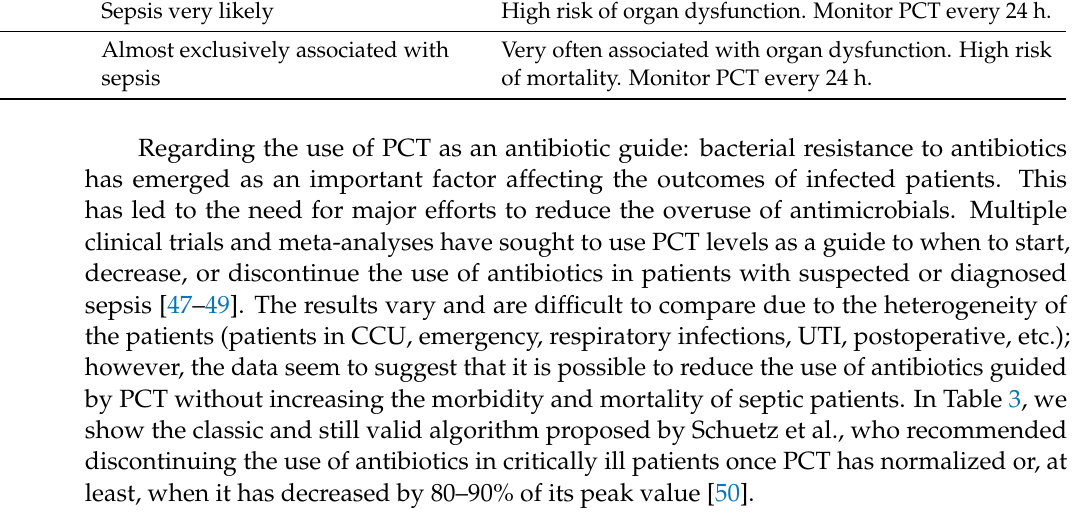
Table 3. Algorithm to guide antibiotic therapy in CCU in patients with suspected sepsis (reevaluation every 1–2